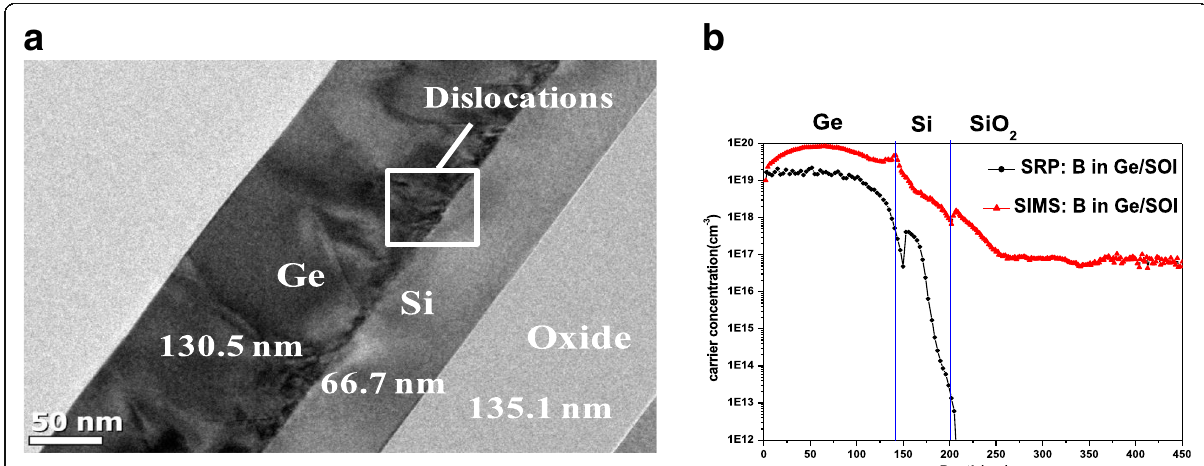
Fig. 2 a The TEM image of the p-type Ge on SOI substrate. b The SIMS and SRP profiles of the in situ boron doped epi-Ge layer on SOI. The hole concentration is low in the bottom defective Ge near Ge/Si interface